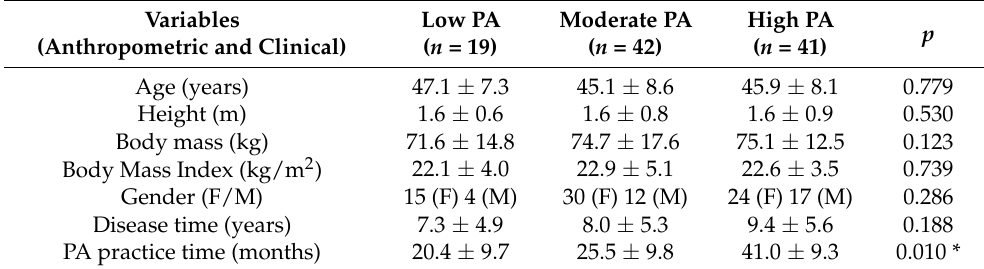
Table 1. Mean, standard deviation and comparisons of the anthropometric and clinical variables among different groups of physical activity levels (PA): low, moderate and high in adults diagnosed with lateral epicondylitis.